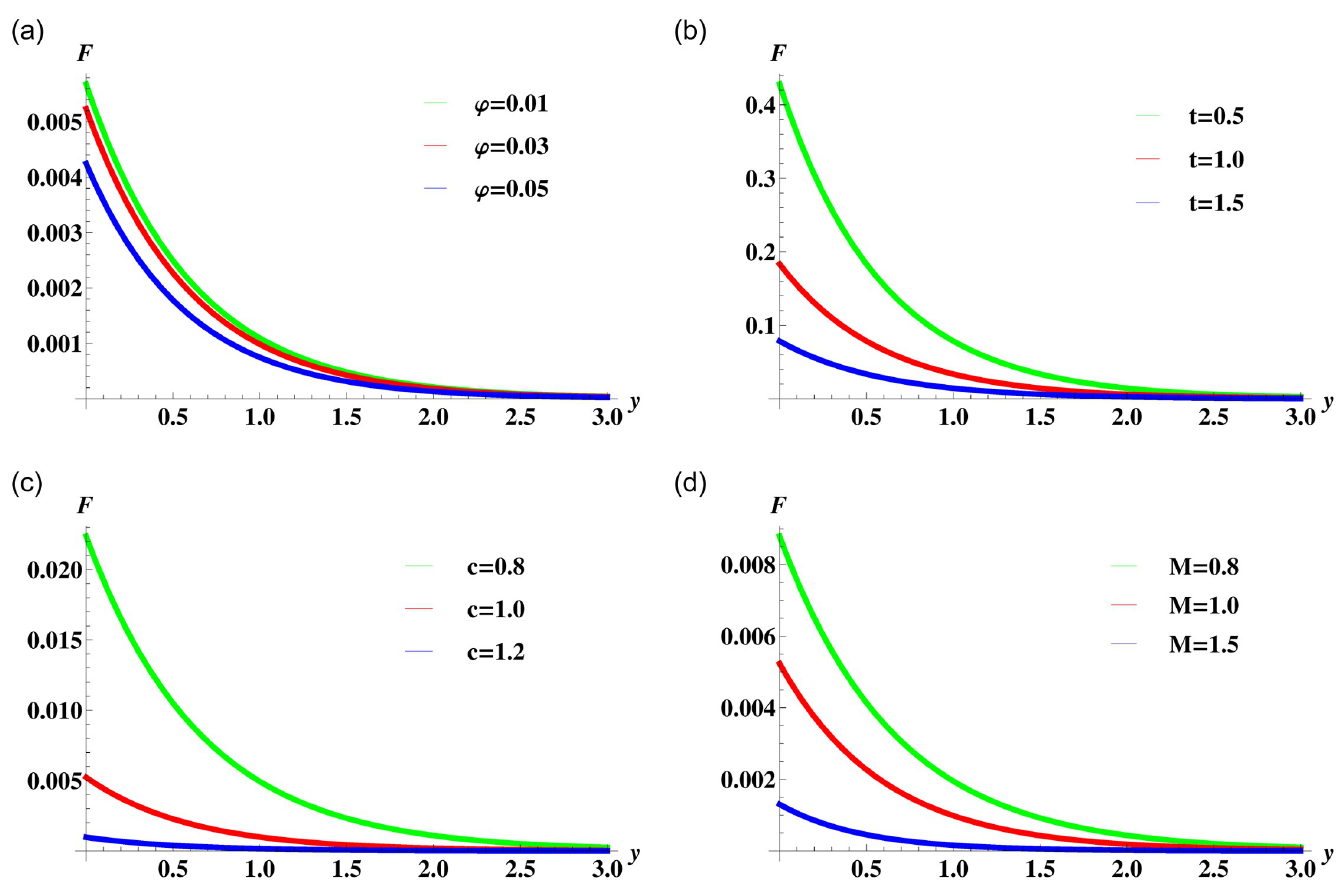
Fig 8. Velocity profile (61) for various values of φ , t , c and M when ρ